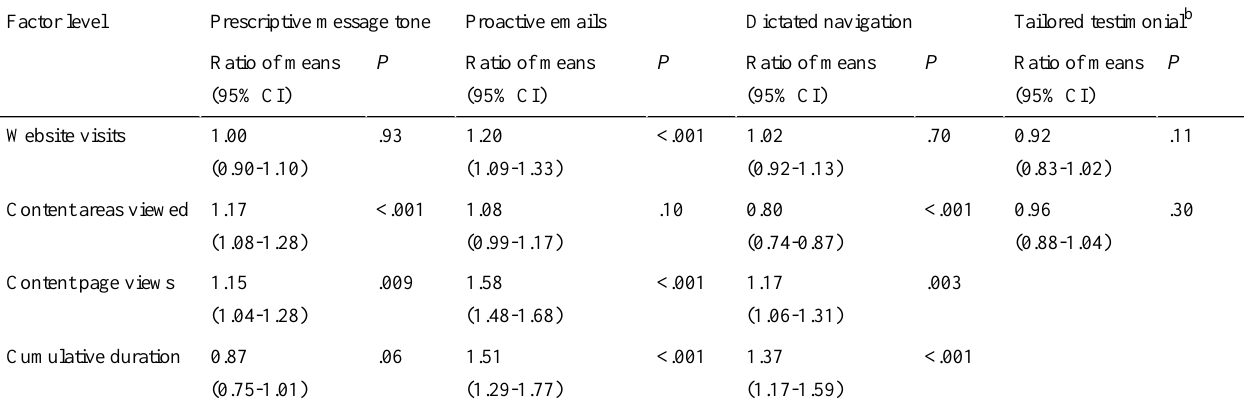
Table 2. Comparison of engagement metrics by factor level.